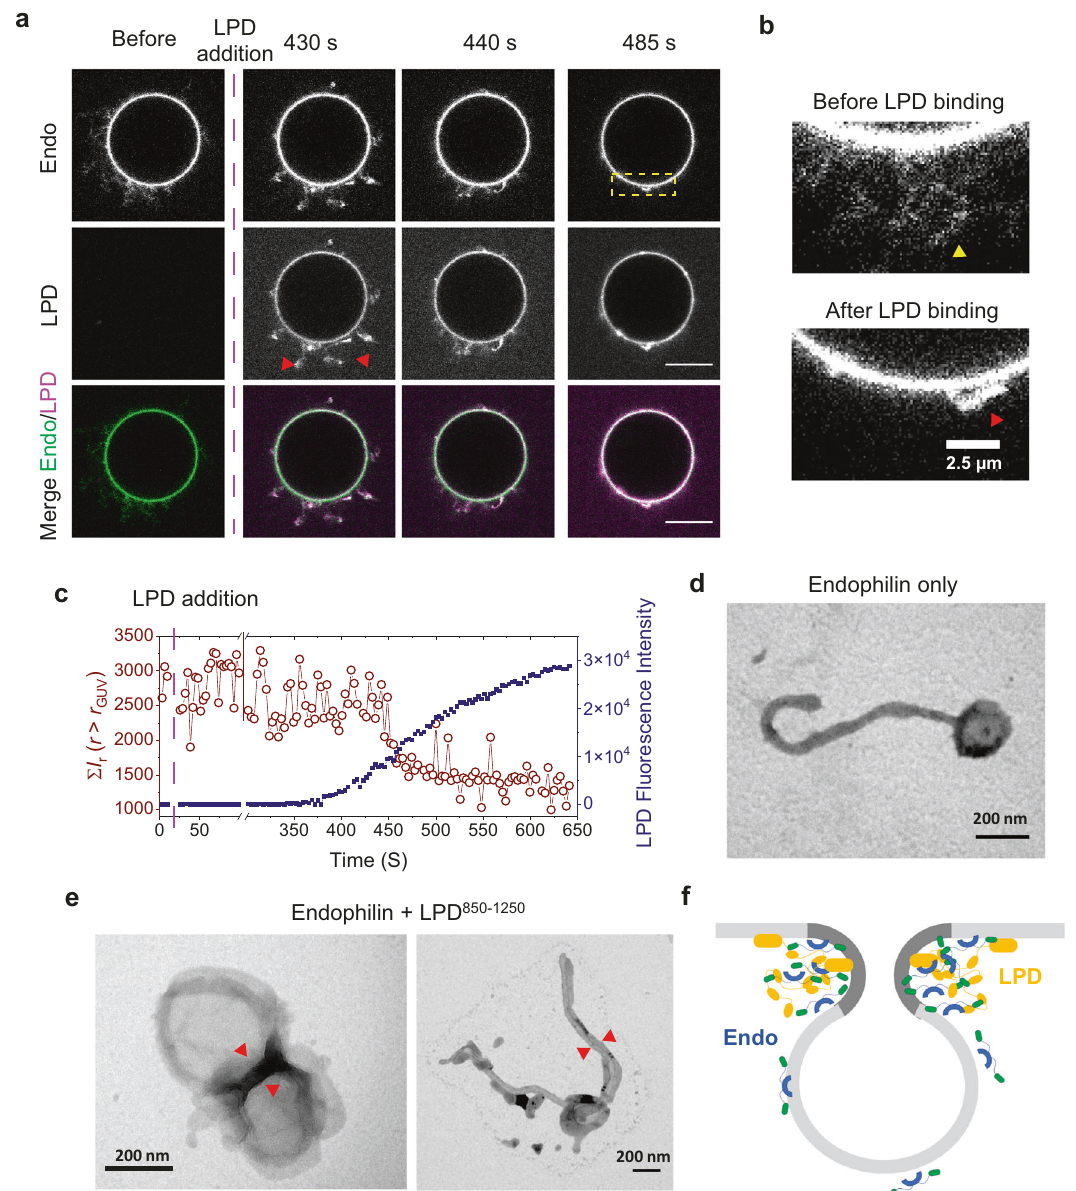
Fig.6|LPDdrivesmembraneadhesioninthepresenceofendophilinandmight stabilize membrane bud formation at FEME sites. a Time-lapse images of GUVs tubulated in the presence ofendophilin before and after the addition of LPD 850 – 1250 showing recruitment of LPD causes contraction of generated tubules. Top panel, GUVs enriched with endophilin (1 µ M, 10% Alexa 488 labeled); middle panel, binding of LPD 850 – 1250 on the GUVs; bottom panel, endophilin and LPD 850 – 1250 chan- nelsmerged.Scalebar10 µ m. b Enlargedlipidchannelimagefromtheboxenclosed region of a to show long tubules present in the absence of LPD (yellow arrow) and small structures (red arrow) formed after contraction of tubules upon LPD addi- tion. c Quantitative analysis showing changes in tubule length correlates with the extent of LPD recruitment onto GUV membrane. To approximately estimate the tubule length,a radialaverageof the intensitiesofthe area outsidethe GUV radius